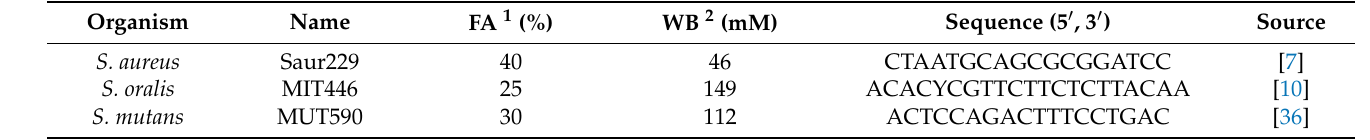
Table 2. Sequence and formamide concentrations of FISH probes used in this